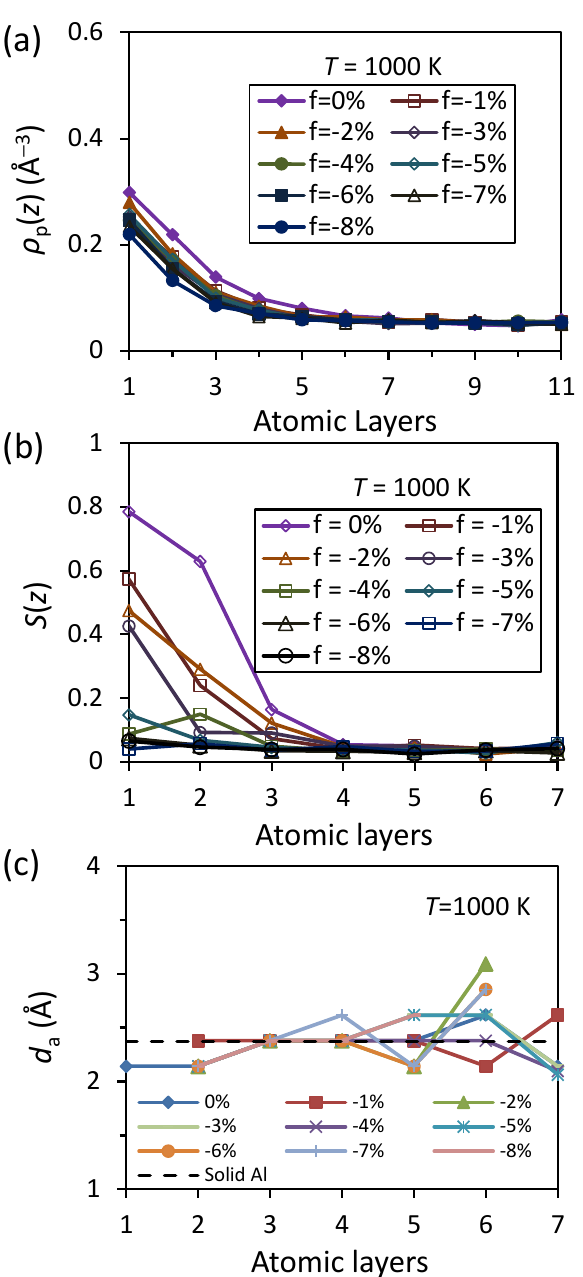
Figure 4. Prenucleation in systems with small negative misfits demonstrated by atomic layering and in-plane ordering [18]. ( a ) Peak density, ρ p ( z ), ( b ) in-plane atomic order parameter, S ( z ), and ( c ) interlayer spacing, d a , in the liquid at the interface are plotted as a function of atomic layers away from the interface for the systems with varied small negative misfit and equilibrated at 1000 K. Atomic layering and interlayer spacing are largely independent of misfit, while the in-plane ordering is strongly enhanced by reducing misfit. (Reprinted with permission from Ref. [18]. Copyright 2022, Spring